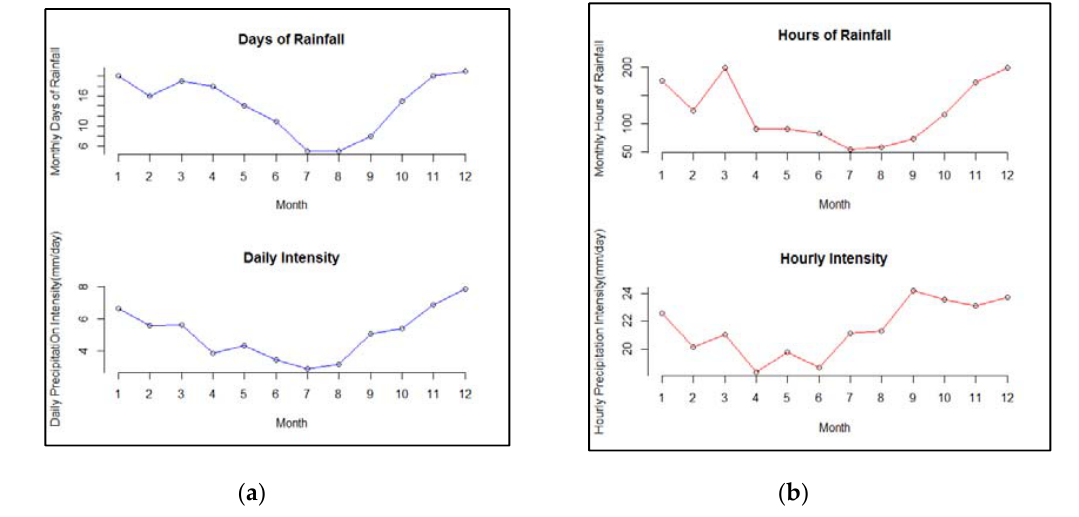
Figure 9. The number of wet days and daily precipitation intensity for each month, averaged for the period of 1999–2015, for Station 04 ( a ). The number of wet hours and hourly precipitation intensity for each month, averaged for the period of record, for Station 04 ( b ).